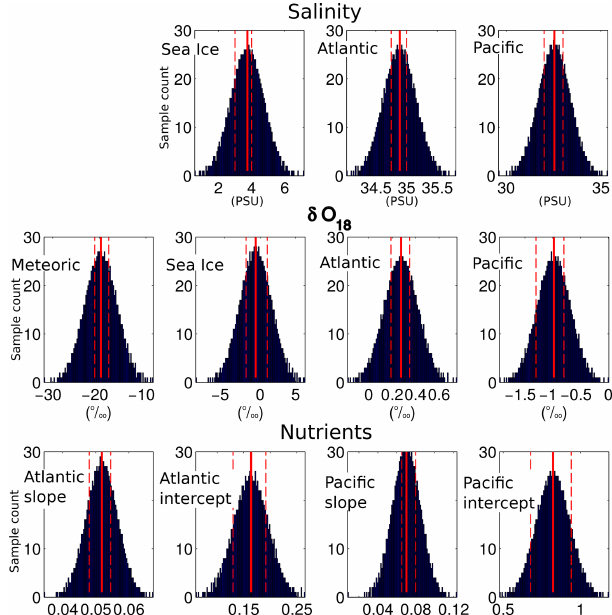
Figure 4. Parameter space for the Monte Carlo simulations. Solid red line indicates the mean of the published values for the parame- ter; dashed red lines indicate maximum and minimum of published